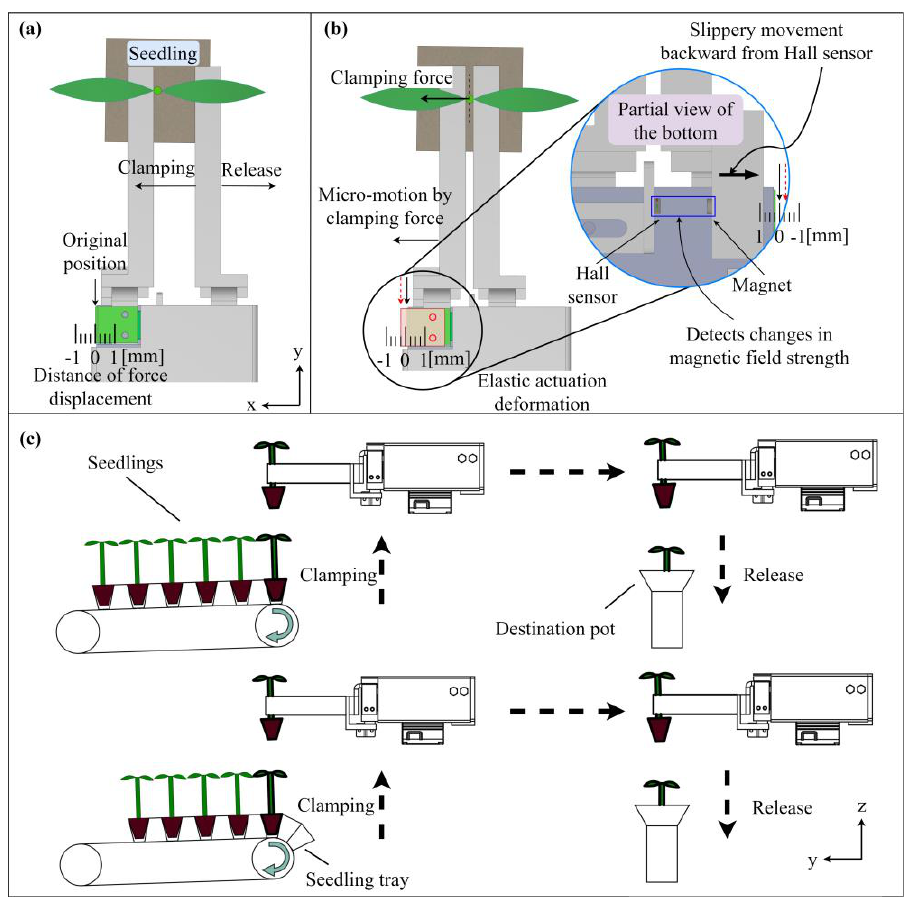
Figure 3. Work process of gripper: ( a ) gripper not in operation; ( b ) gripper in operation; ( c ) operation process of gripper.